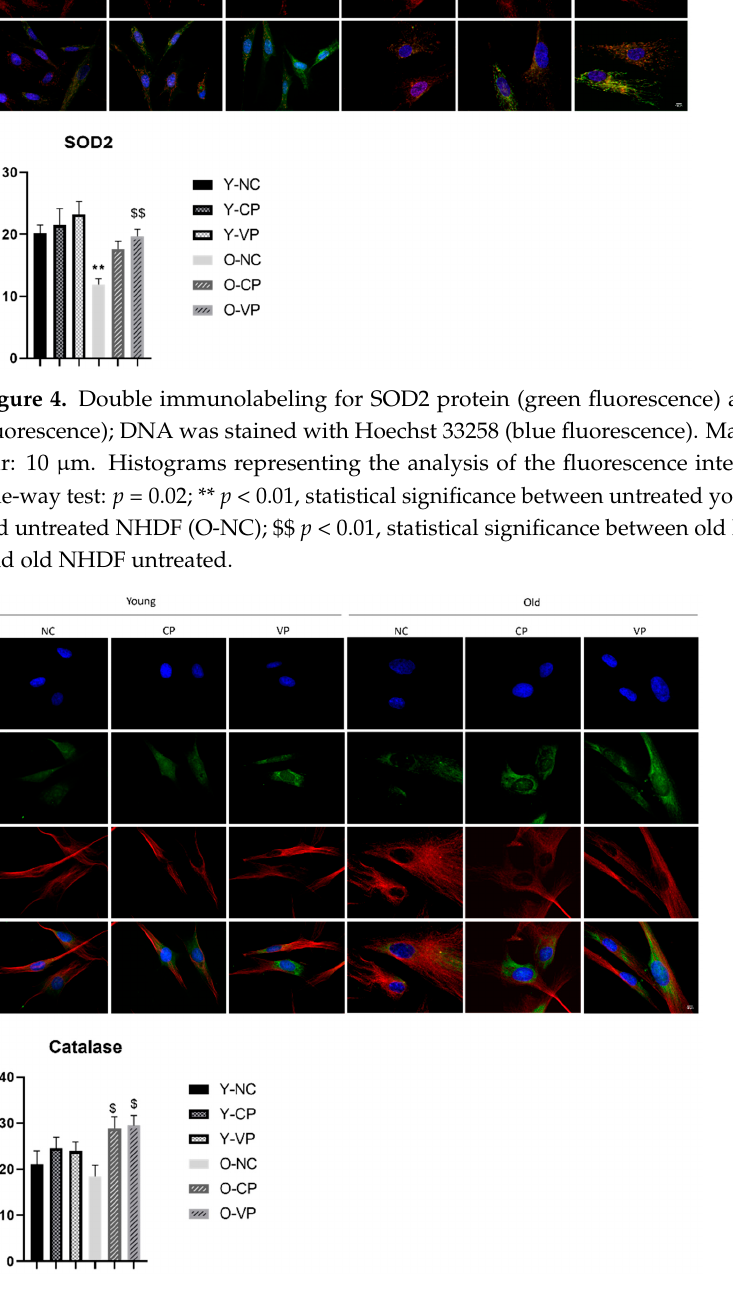
Figure 5. Double immunolabeling for protein catalase (green fluorescence) and α -tubulin (red fluorescence); DNA was stained with Hoechst 33258 (blue fluorescence). 60× magnification; scale bar: 10 μ m. Histograms showing the analysis of catalase fluorescence intensity; Anova one-way test: p = 0.01; $: p < 0.05, statistical significance between old NHDF treated and old NHDF untreated.